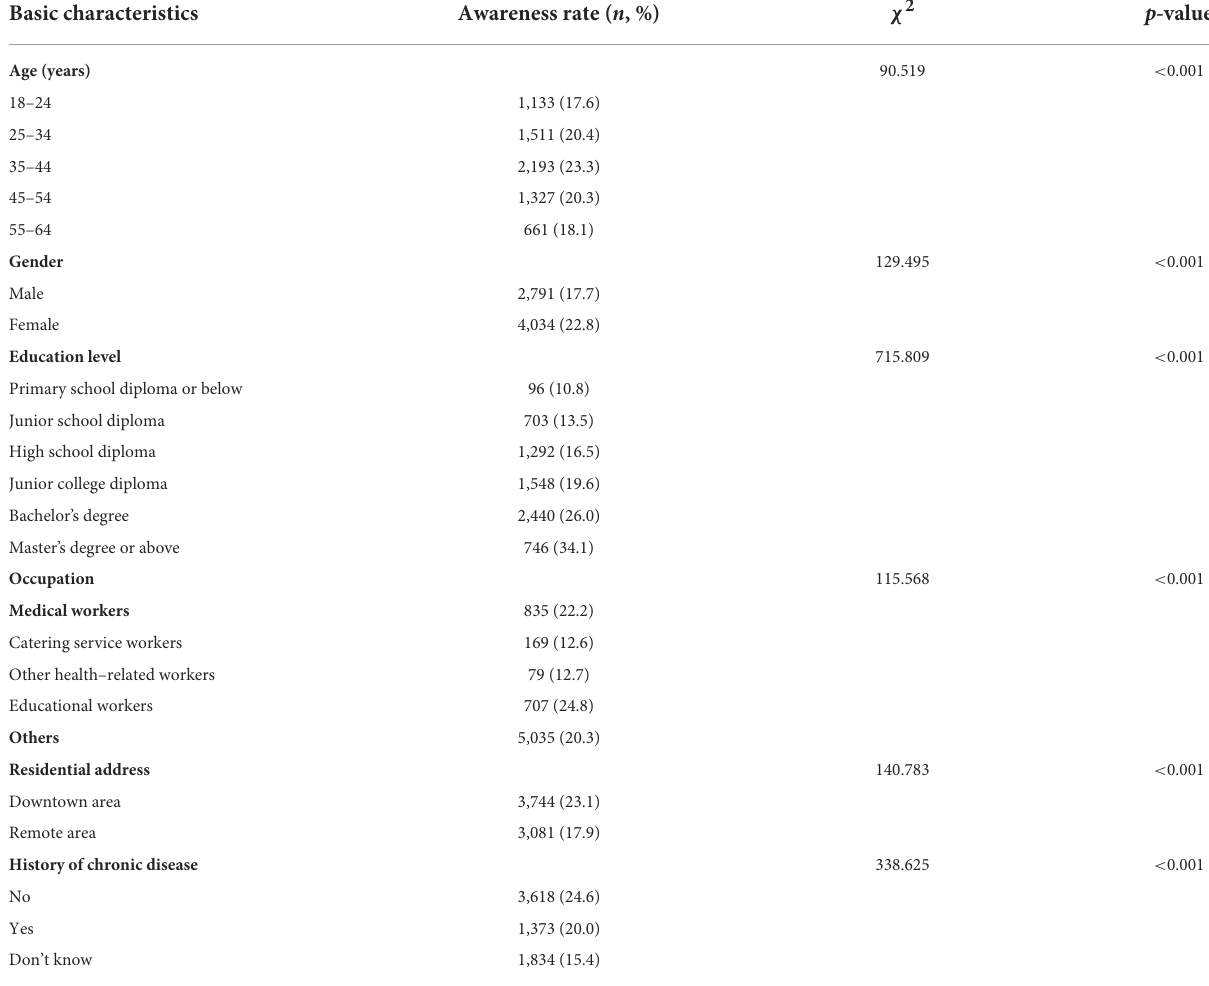
TABLE 3 Correlation of respondents’ sociodemographic characteristics and the awareness rate of nutrition and health knowledge. Basic